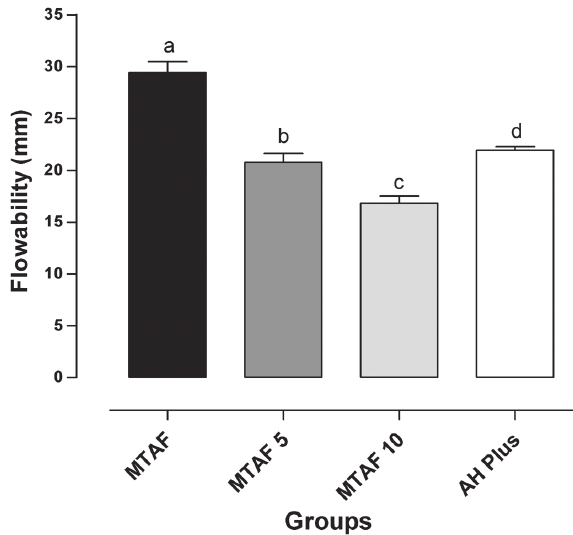
Figure 1- Flowability values from each sealer evaluated (in mm). Different letters indicate statistically significant differences